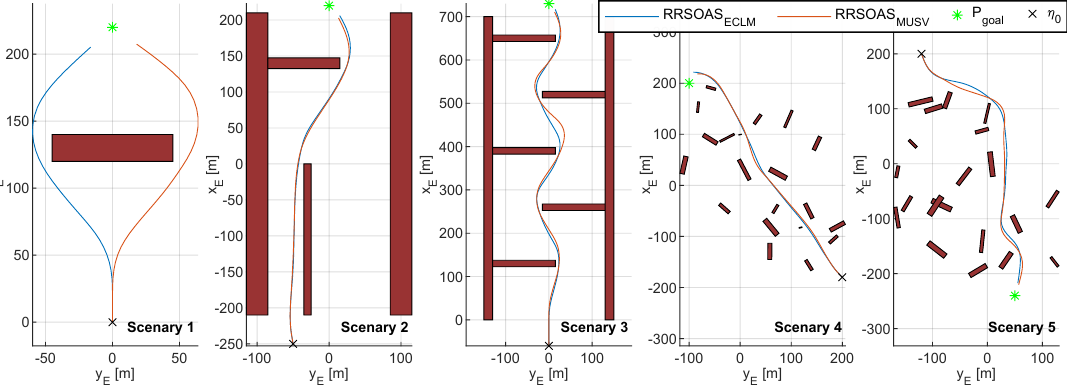
Figure 12. A comparative of the RRSOAS operating with two prediction models: ECLM (28) and USVM—(1), (3), (4) and (5). The adjustment parameters used can be found in Table